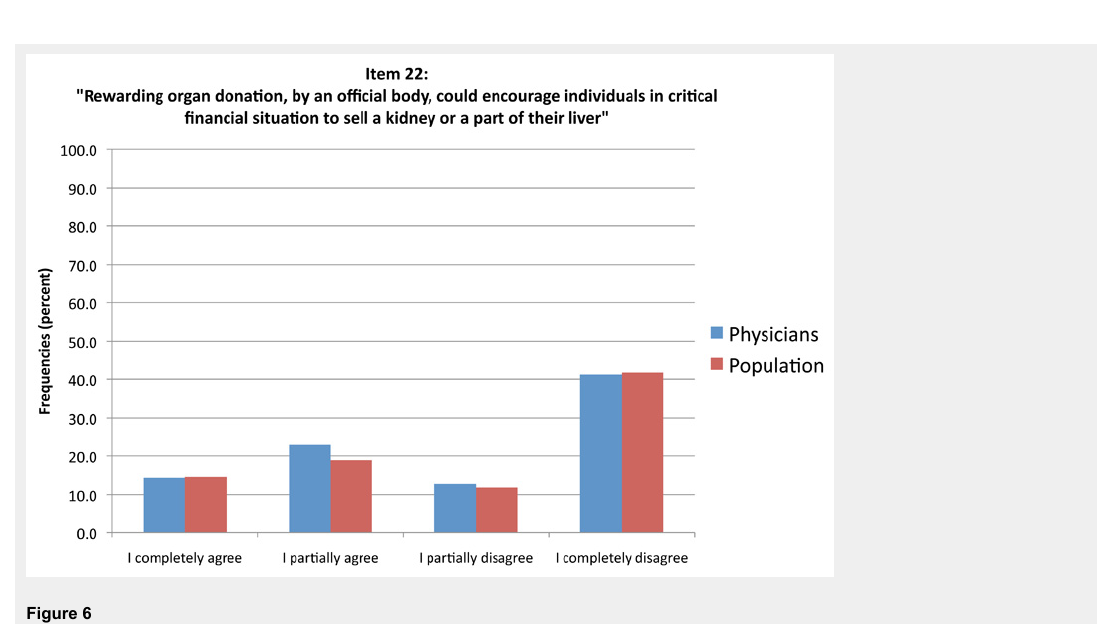
Figure 6 Physicians’ and inhabitants’ answers for item